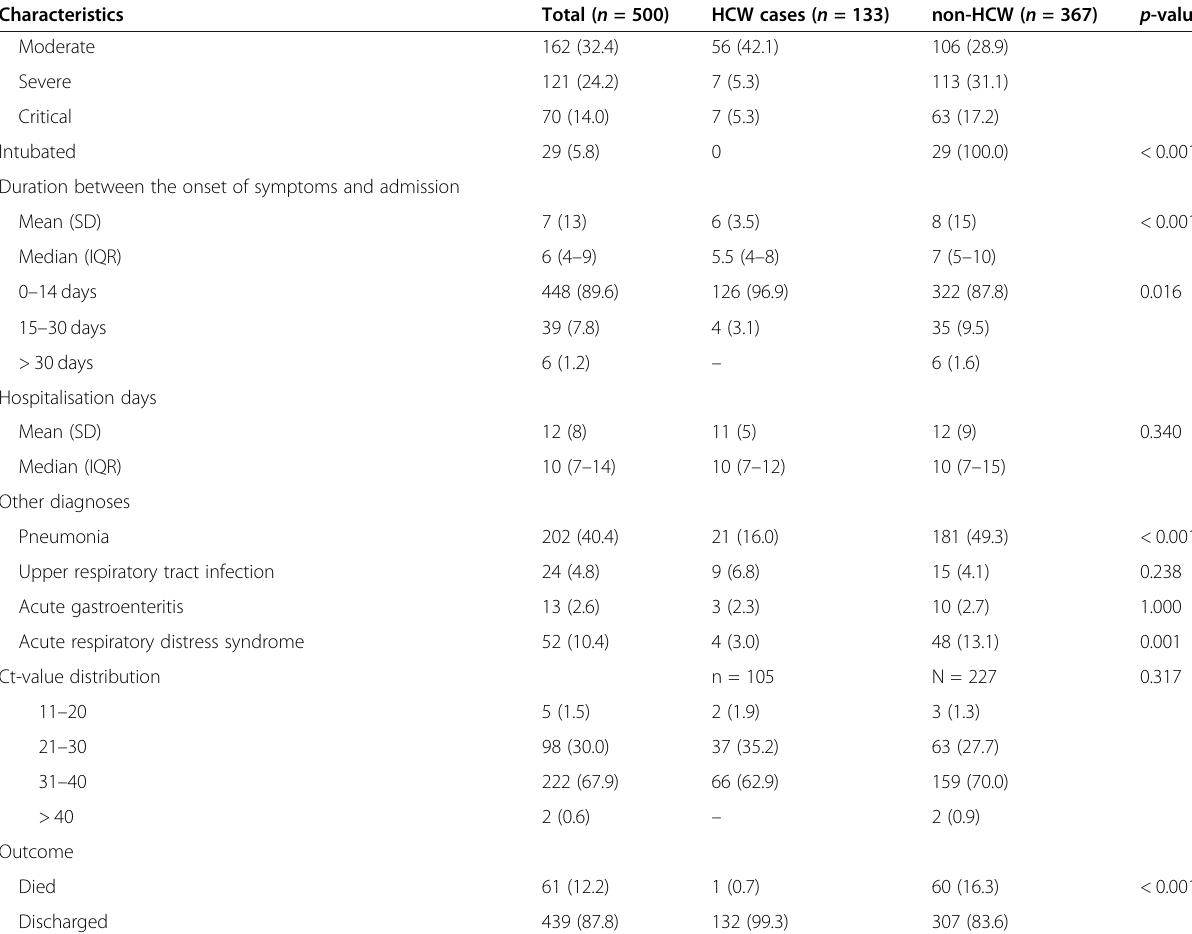
Table 1 Epidemiologic and clinical characteristics of healthcare and non-healthcare workers COVID-19 inpatients in San